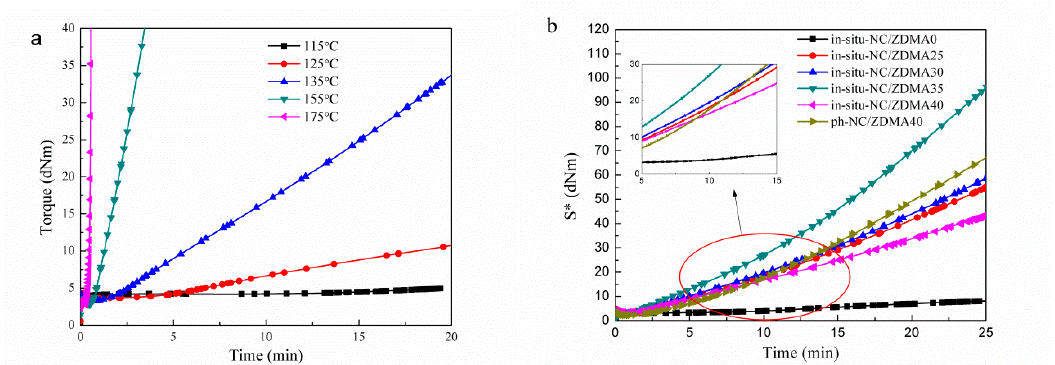
Figure 4. ( a ) Curing curves of in-situ-NC/OMMT40 at 115,125,135,145, and 155 °C, ( b ) curing curves of in-situ-NC/ZMDAs and ph-NC/ZDMA40 at 135 °C.